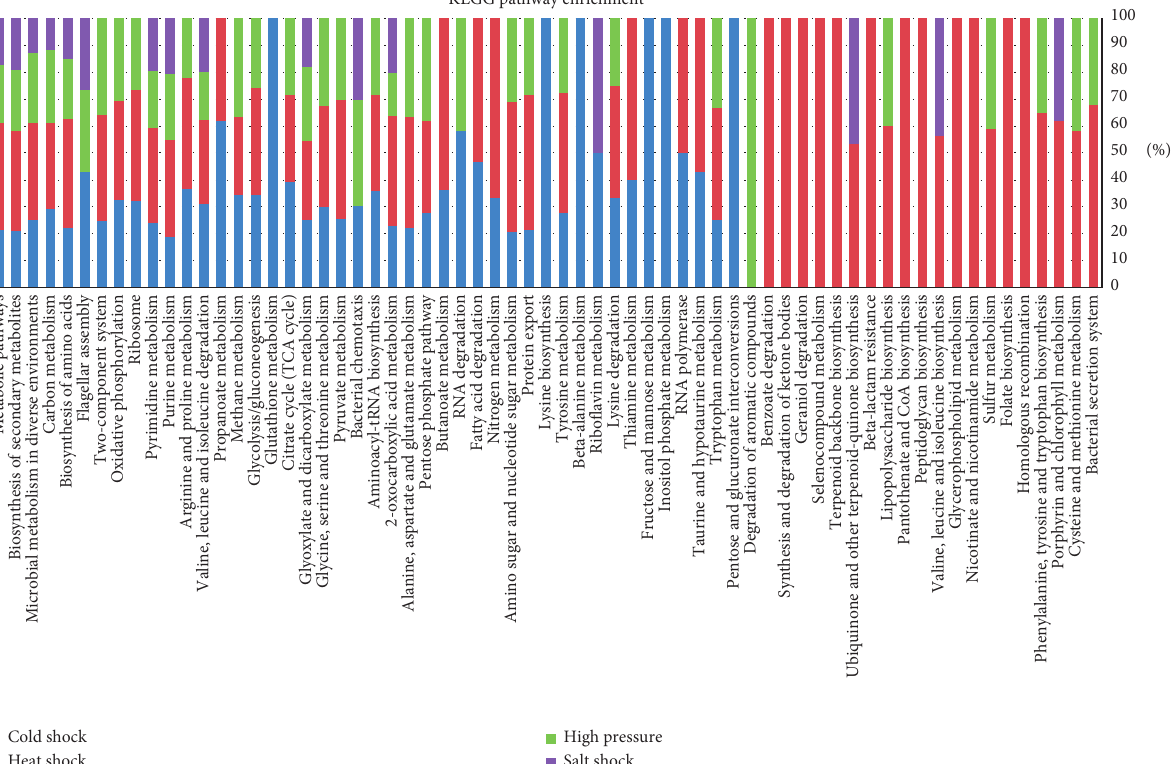
Figure 2: KEGG pathway enrichment analysis for the DEGs (differentially expressed genes) under the various environmental conditions. False discovery rate < 0.05.